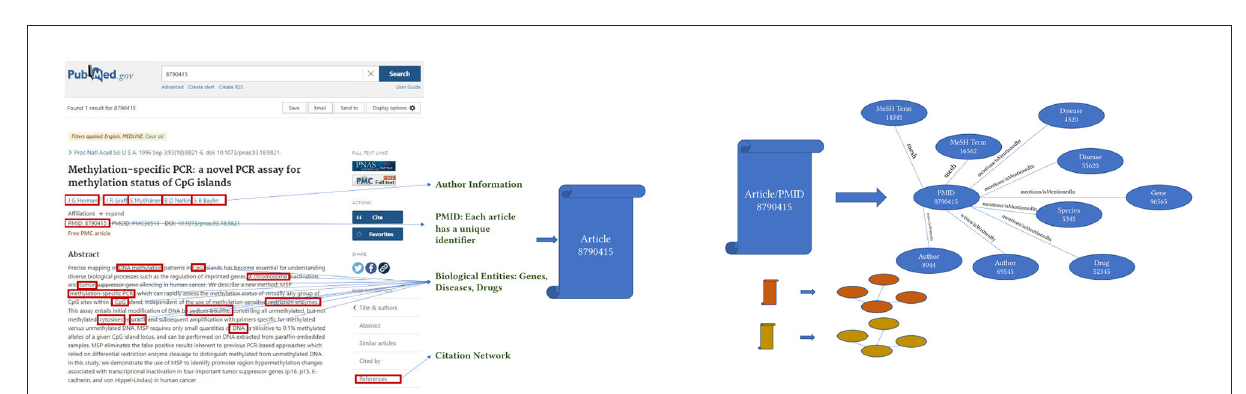
A table containing PubMed articles’ bibliographic information. A table containing PubMed authors and their unique identifiers. A table containing all types of extracted bio-entities by BioBERT are used in both building the Knowledge Graph and as an index. A table containing affiliations and extracted fine-grained items. A table containing projects from NIH ExPORTER and mapping relation between PI_ID, PMID, and AND_ID. A table containing reference relations between PMID and reference PMID. It was extracted from the Web of Sciences.